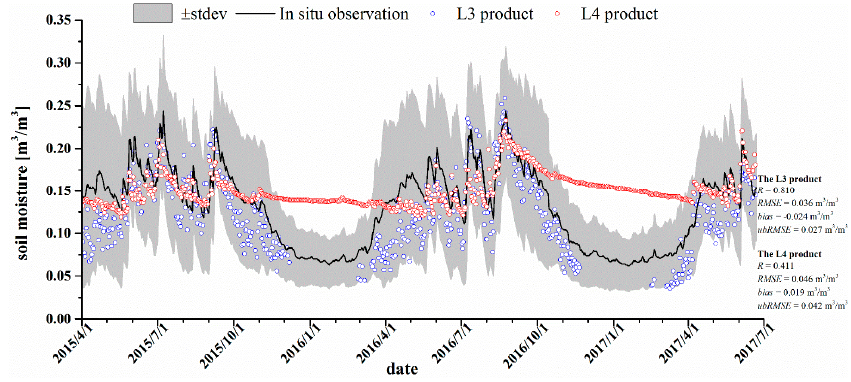
Figure 2. Time series of daily areal average values of the SMAP L3 and L4 products and in situ observation in the study area.